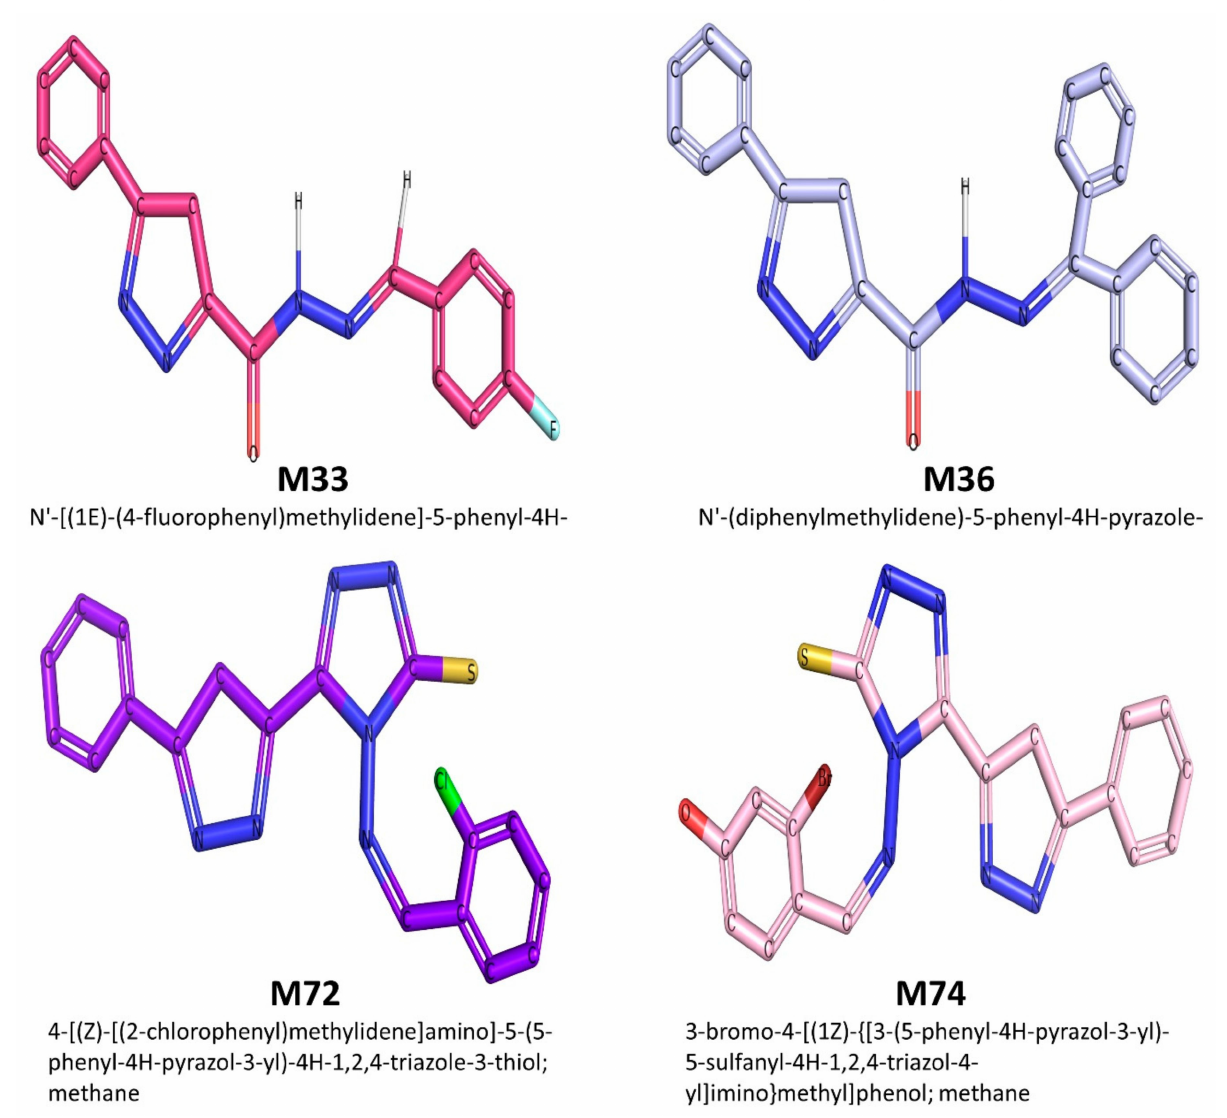
Figure 1. The top-ranked compounds selected from the 63 synthesized pyrazoles